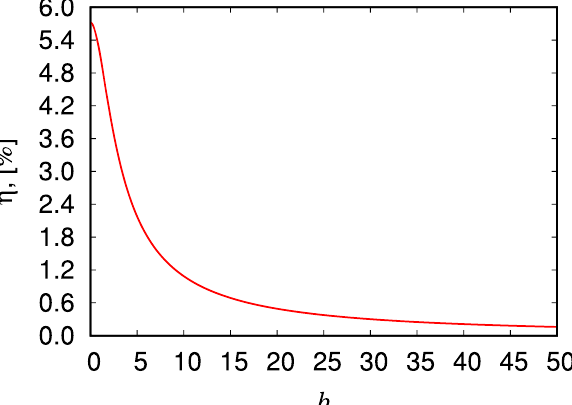
Fig. 3 The energy efficiency η with respect to the parameter b in quantum-corrected Schwarzschild black